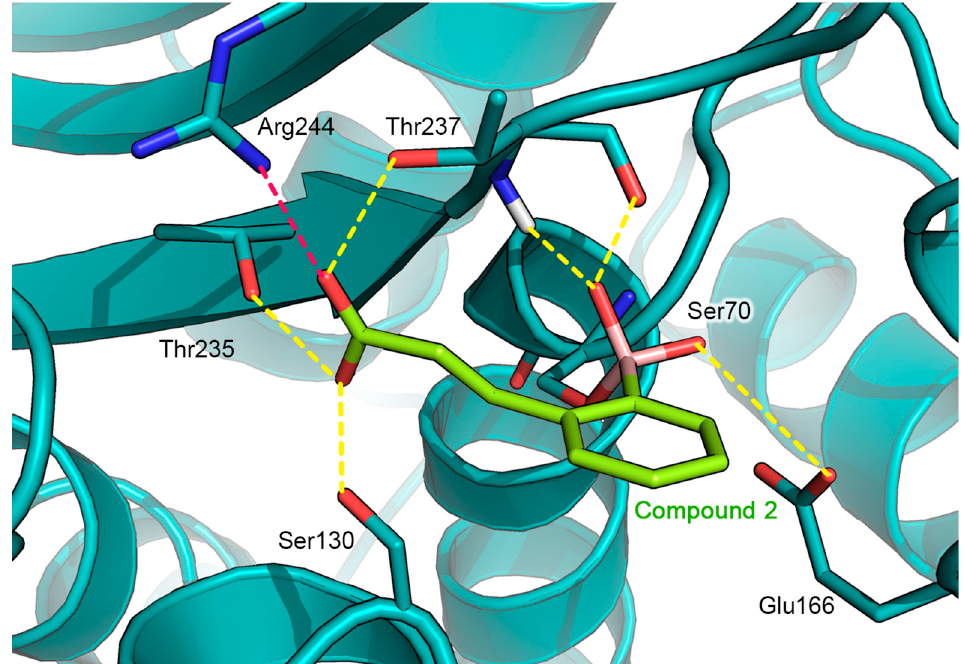
Figure 2. Docking pose of compound 2 (in green) as predicted in GES-5 active site (PDB ID: 6Q35, teal cartoon). Key catalytic residues are reported in deep teal sticks. H-bond are shown as yellow dashed line and the salt bridge in the magenta dashed line. Heteroatoms are color-coded (oxygen in red, nitrogen in blue, boron in pink).